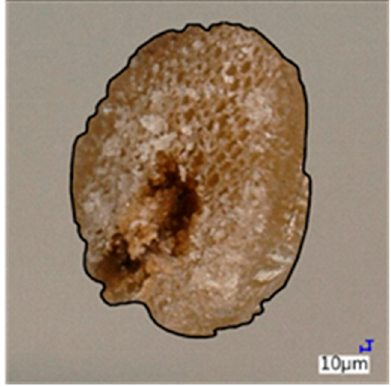
Figure 6. Area calculation.